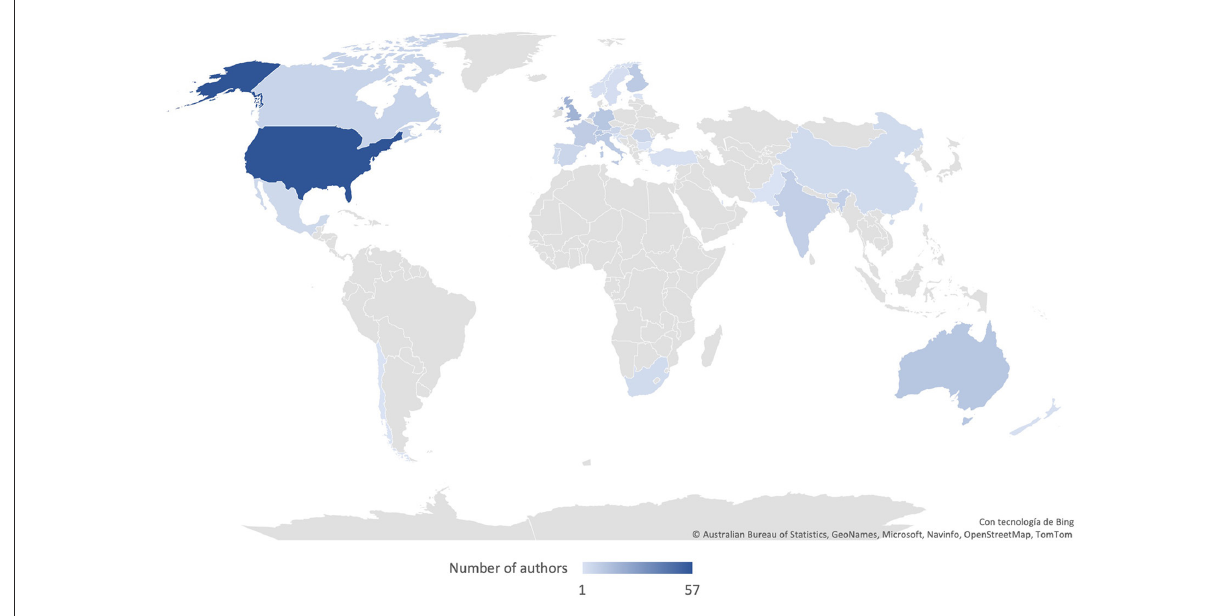
FIGURE6 Authors by the country of their